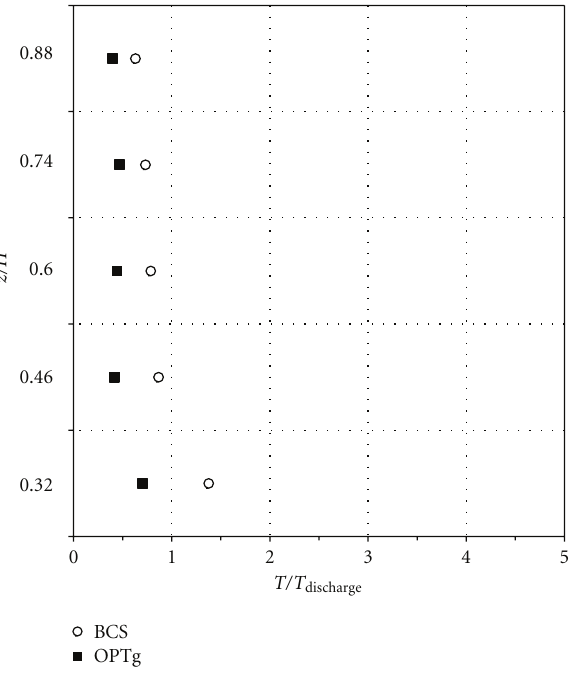
Figure 16: Comparative profiles of nondimensional internal food product temperature, T/T discharge ( y/W = 0 . 33, z/H )—OPTg case